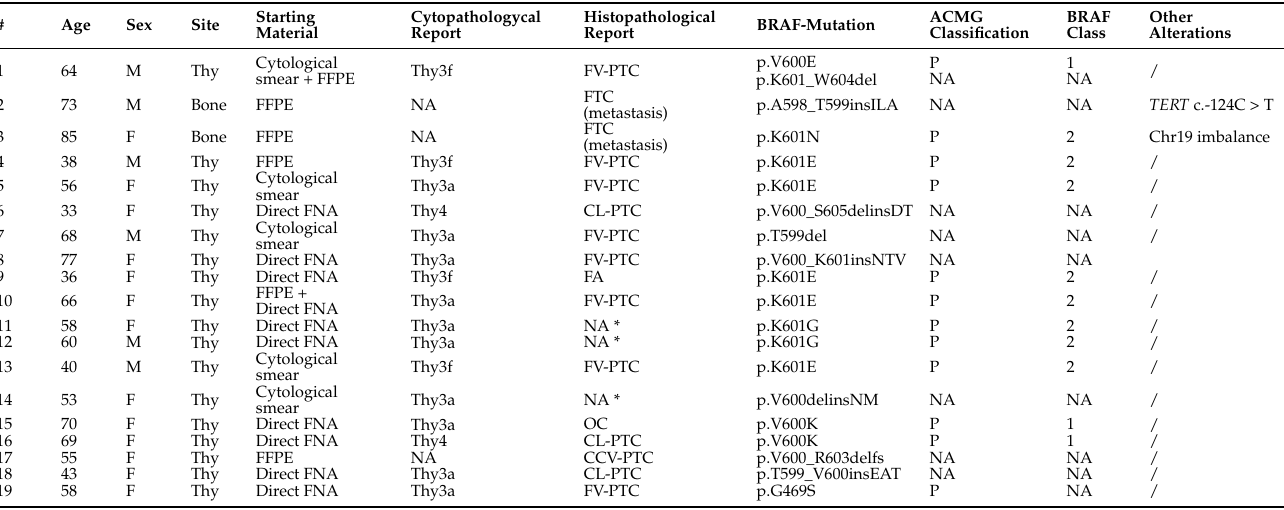
Table 2. Cases harboring BRAF non-V600E Mutations.